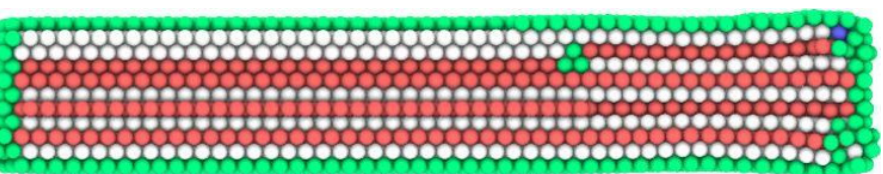
Fig. 20. Cut of the amorphized nanorod by the plane perpendicular to the Y axis, at the time instant 2 ps after the cyclic loading start.  x 0 = 0.5 Å,  =1 THz. Green shows the surface atoms and other structureless ones; white shows the atoms forming the FCC lattice; blue shows the atoms forming the BCC lattice; red shows the atoms forming the FCCP